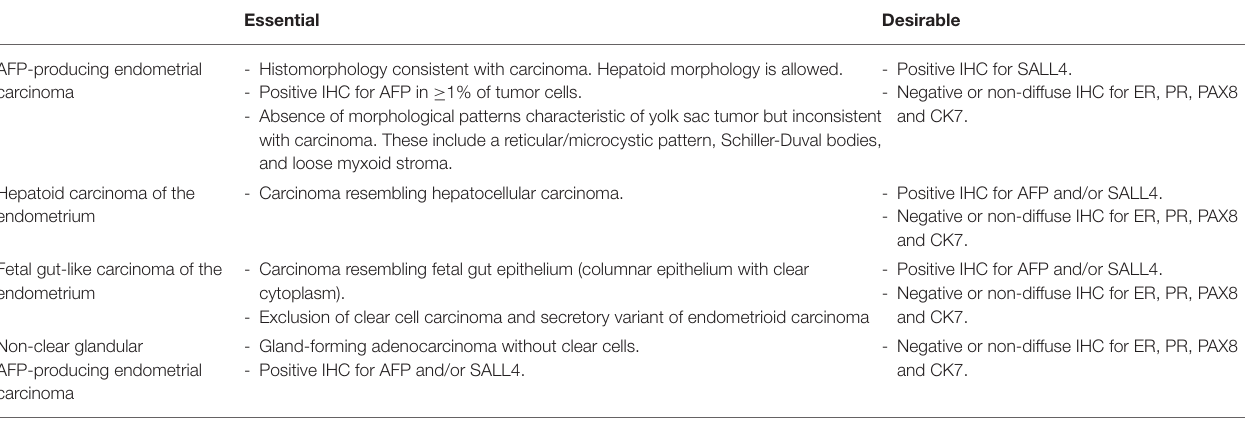
TABLE 4 | Proposed essential and desirable diagnostic criteria for AFP-producing endometrial carcinomas. Essential